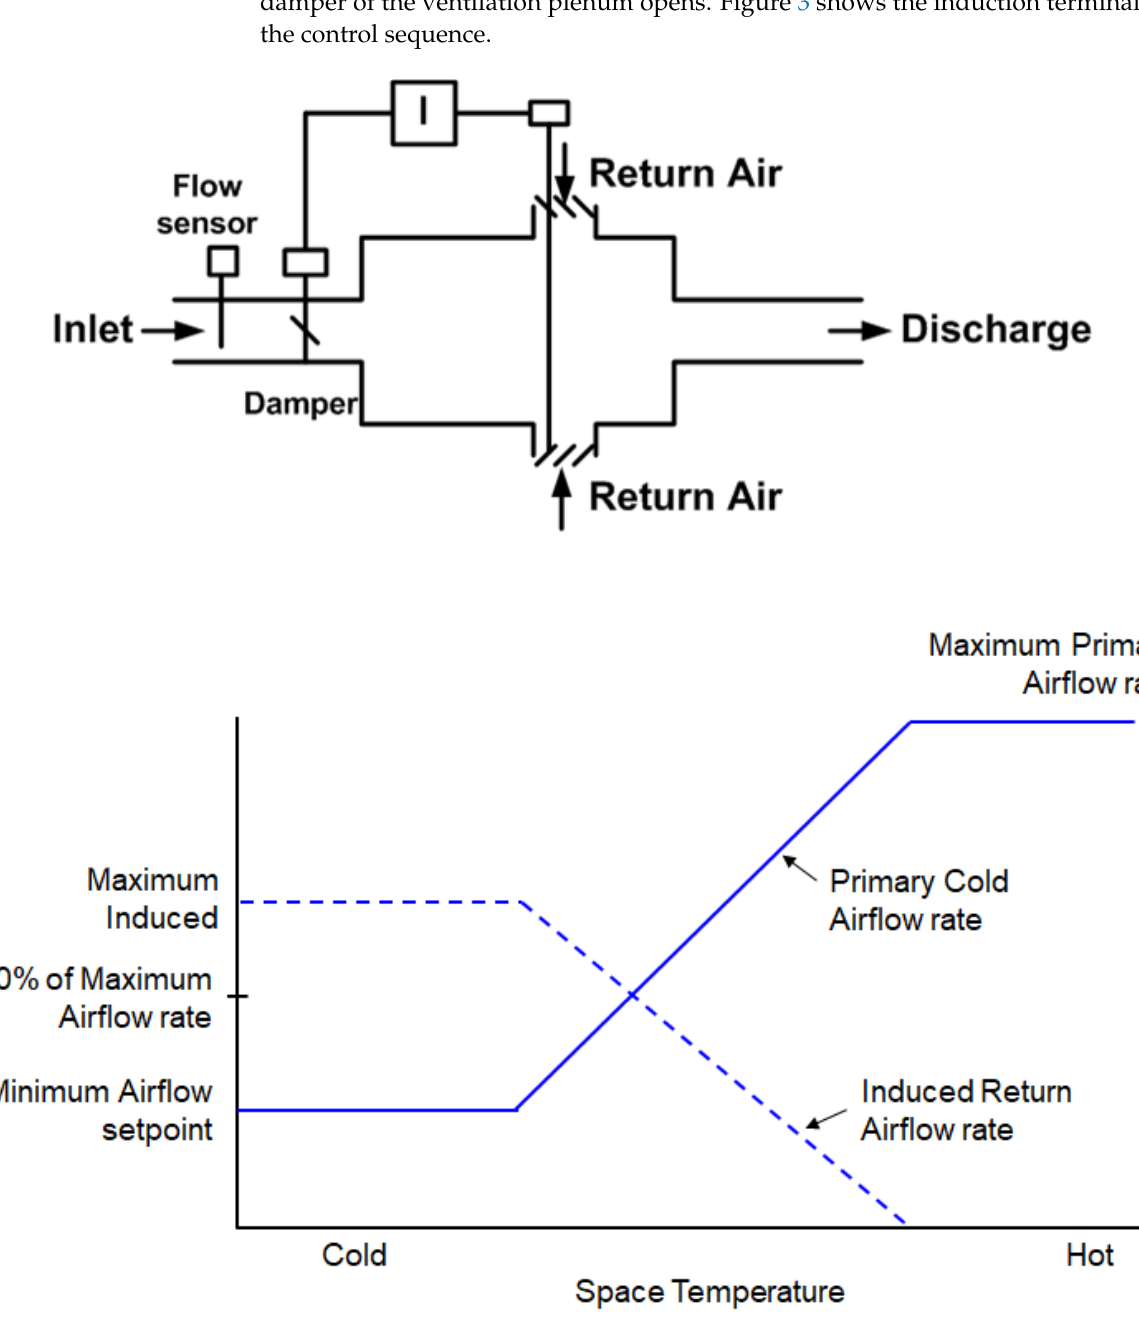
Figure 3. Induction VAV terminal unit and control sequence [16].